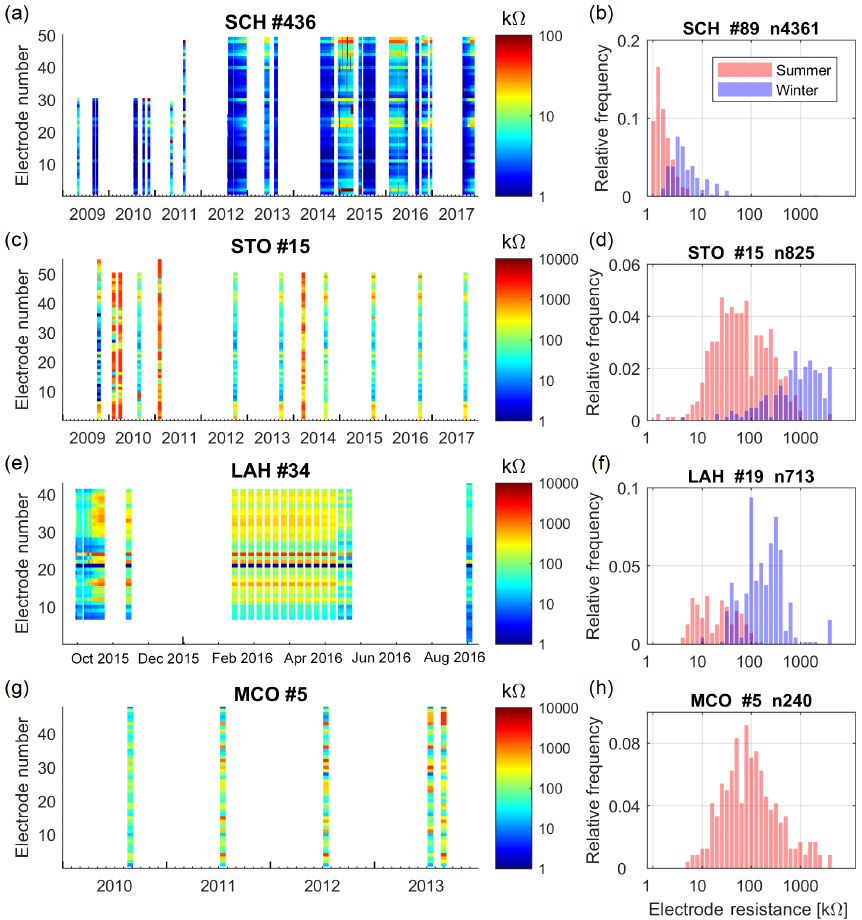
Figure 4. Temporal evolution of contact resistances and seasonal variations in contact resistance histograms at (a, b) SCH, (c, d) STO, (e, f) LAH and (g, h) MCO. Summer (red) is hereby defined as the 3 months with thawing processes and an absence of snow cover (JAS), while January to March (JFM) represent the winter conditions (blue). No winter values are available for MCO. Note the different time and colour scales. The symbol “#” denotes the number of datasets, and “ n ” the total number of electrodes taken into account in the